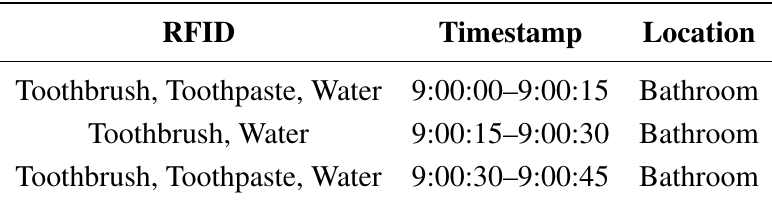
Table 2. The aggregation of the brushing teeth activity observations into 15 s group.